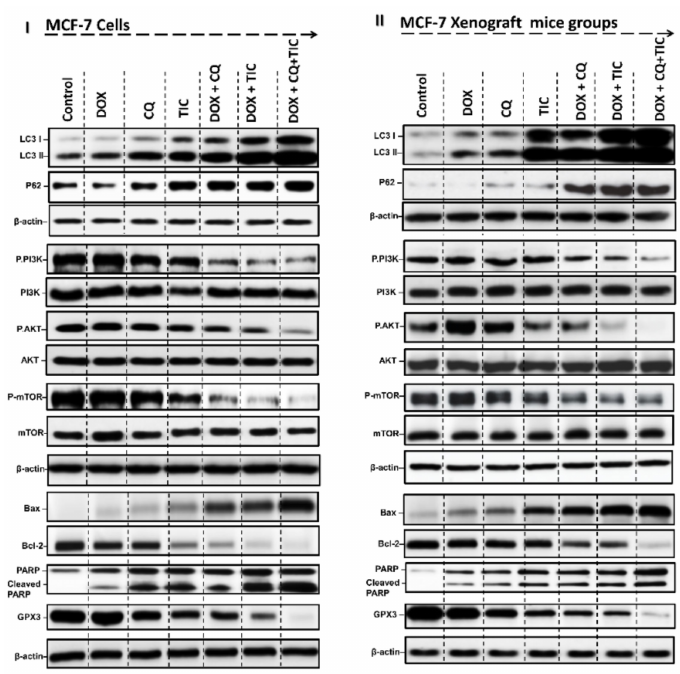
Figure 7. Autophagy inhibition induces cell death-dependent apoptosis. Representative Western blots of autophagic markers (LC3I/II) and p62, PI3K/AKT/mTOR pathway markers, apoptotic and anti-apoptotic markers (Bax, Bcl-2), GPX3 (anti-oxidant marker) proteins expression levels of MCF-7 cells ( I ) and MCF-7 Xenograft mice ( II ) treated with single or combinatorial